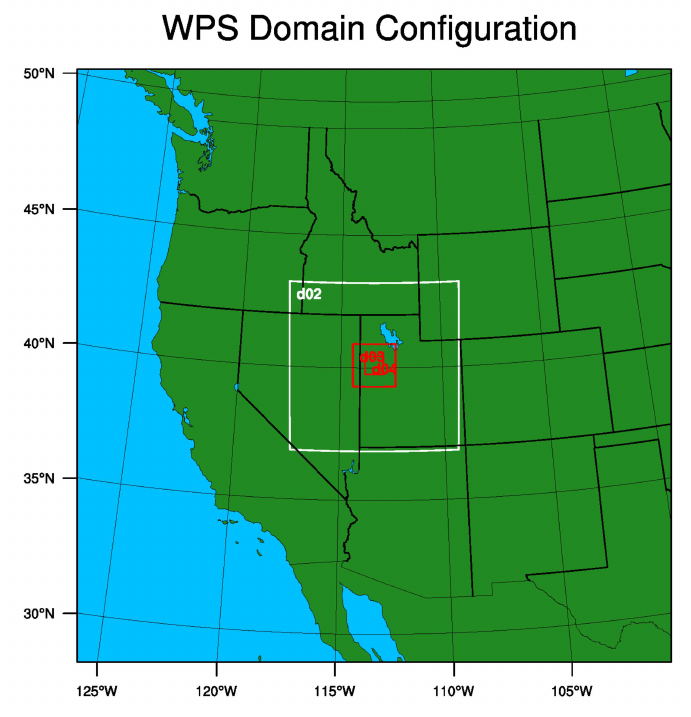
Figure 4. WRF nest domains centered on DPG.